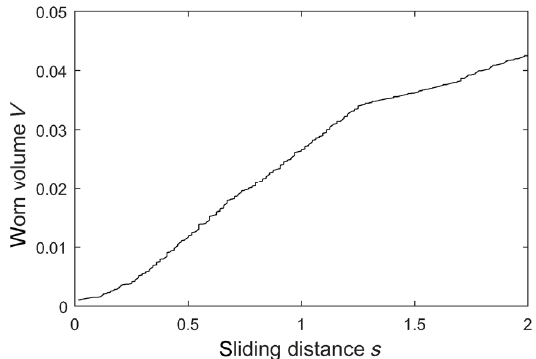
Fig. 11 Dependency of the worn volume as a function of the sliding distance covered. Mean pressure was 1   p (circled value in Fig. 12), other parameters as in Fig.